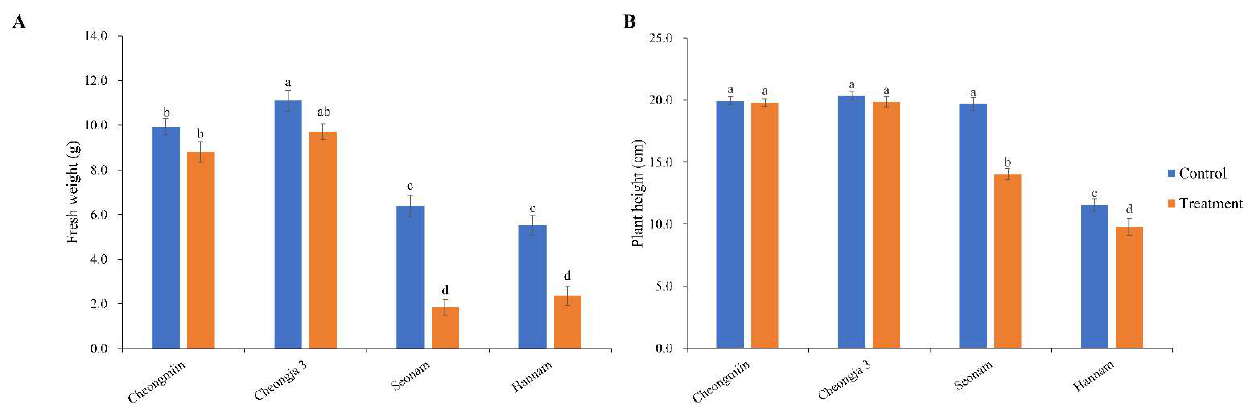
Figure 4. Growth parameters of ( A ) fresh weight and ( B ) plant height of bentazone-treated and control plants measured 14 days after treatment. Error bars indicate standard error. Different letters denote statistically significant differences at p < 0.05.